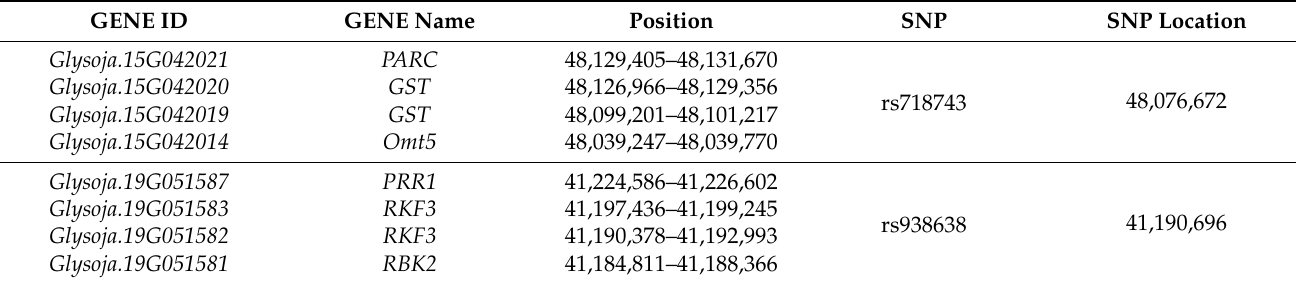
Table 8. Candidate genes associated with PRR